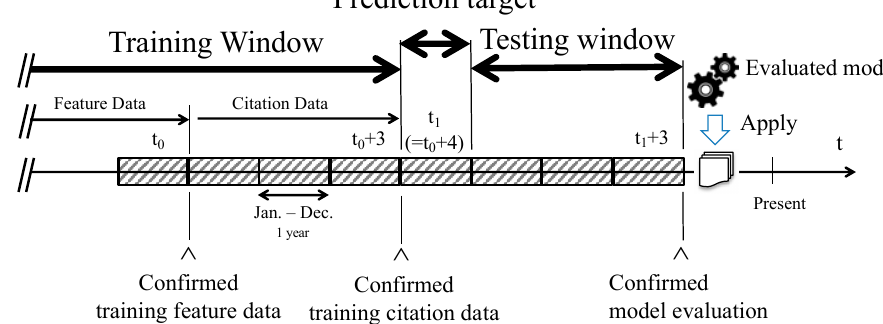
Figure 2. Model training and prediction.